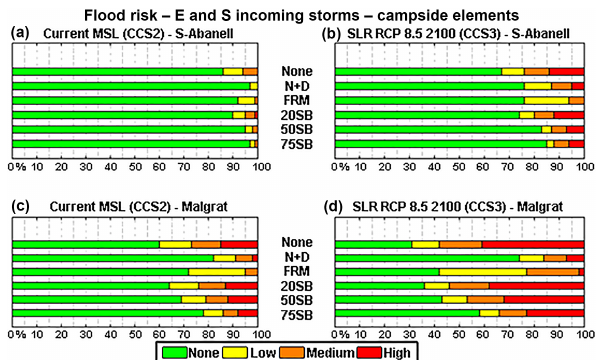
Figure 12. Distribution of campsite elements at every level of flood- ing risk: (a) climate change scenario 2 (incoming storms from E and S) at S’Abanell; (b) climate change scenario 3 (incoming storms from E and S + SLR) at S’Abanell; (c) climate change scenario 2 (incoming storms from E and S) at Malgrat; (c) climate change sce- nario 3 (incoming storms from E and S + SLR) at Malgrat. Each bar in a panel represents a risk reduction configuration (“none”: no measure implemented; “N + D”: nourishment and dune; “FRM”: flood resilience measures; “20SB, 50SB, and 75SB”: 20, 50, and 75m setbacks, respectively).